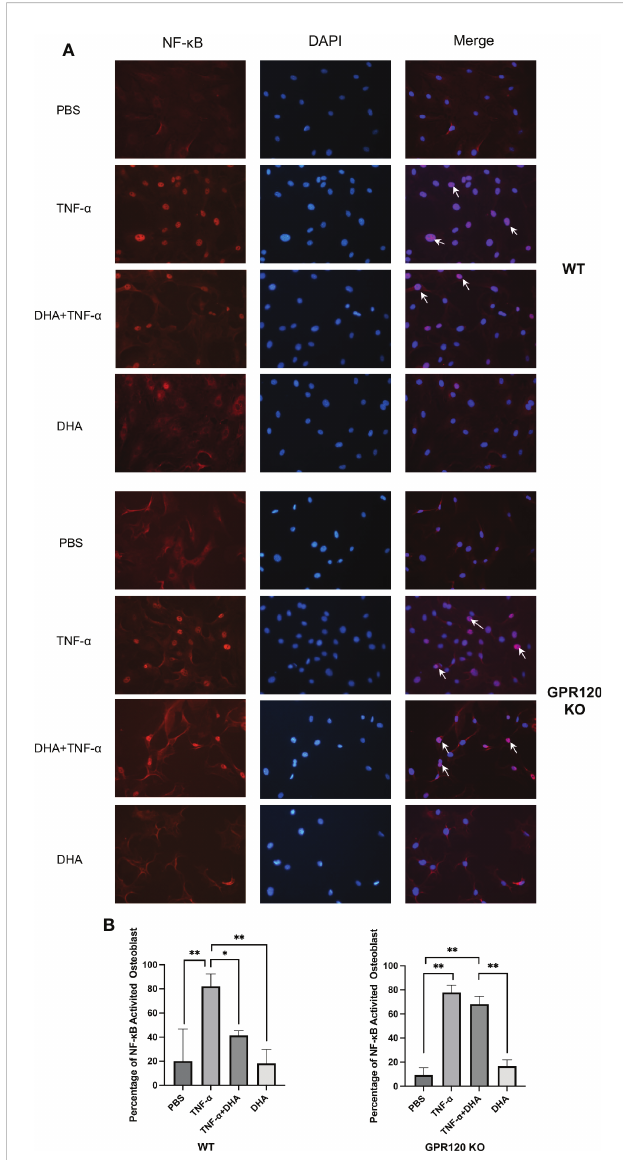
FIGURE 5 Effect of DHA on NF- k B activation by TNF- a in osteoblast. (A) Fluorescent images of WT osteoblast stained for NF- k B p65 antibody and Alexa Flour 555; DAPI was used as control. NF- k B activated osteoblast were indicated by arrows. (B) NF- k B activated osteoblasts number to the total number of osteoblasts. The results are given as means ± SD. Scheffe ́ ’ s test was used to determine the statistical signi fi cance of differences (n = 4; * p < 0.05, ** p < 0.01). Scale bars = 50 m